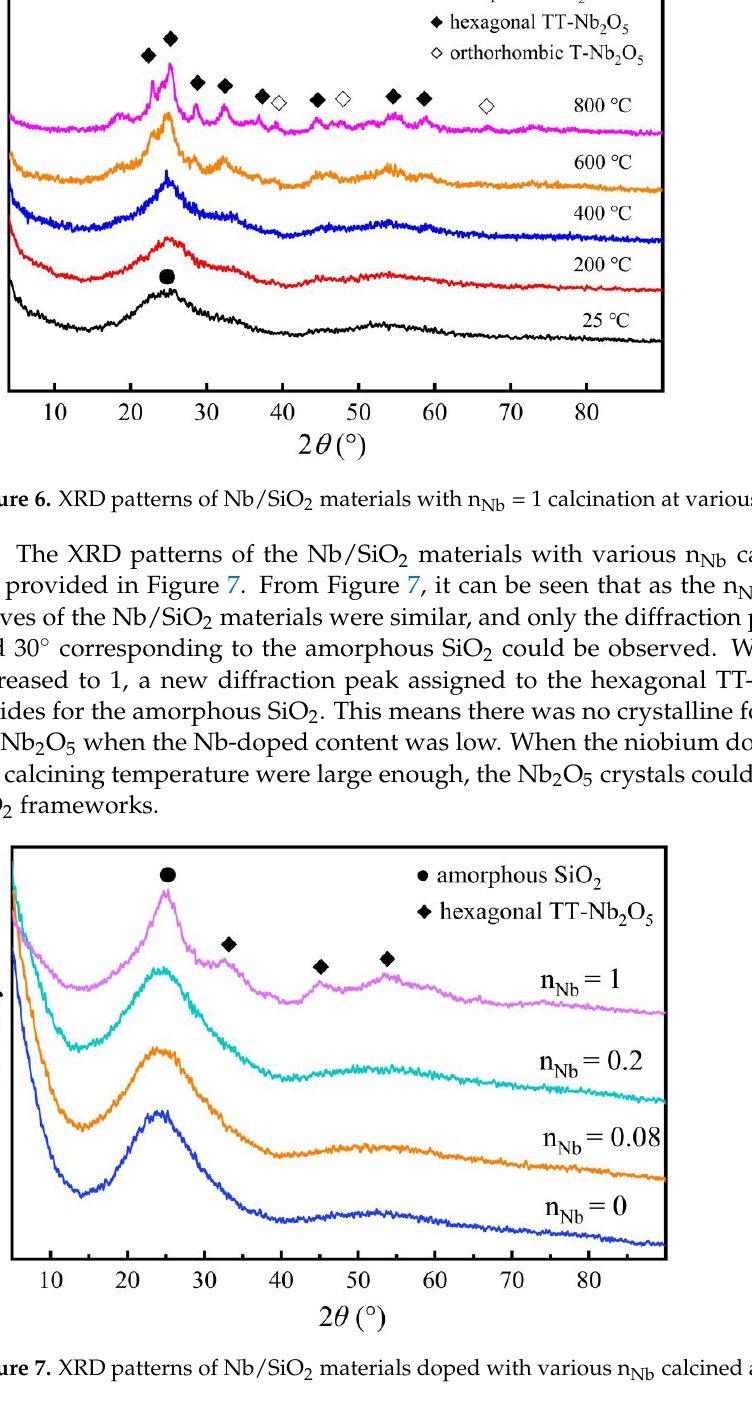
Figure 7. XRD patterns of Nb/SiO 2 materials doped with various n Nb calcined at 400 °C.